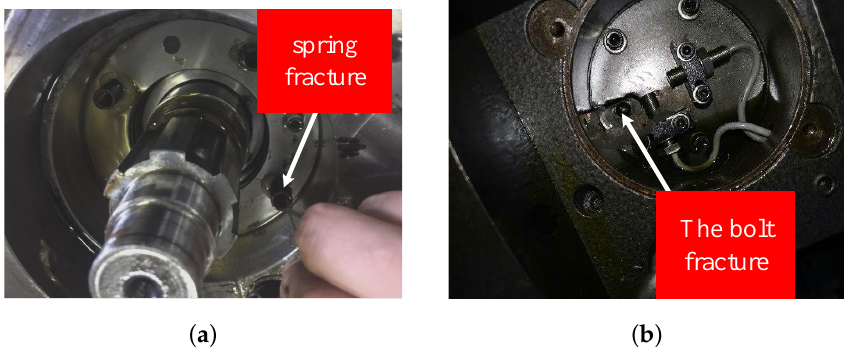
Figure 3. Two failures in the reliability test: ( a ) a failure of the lock and loosen component, ( b ) a failure of the signal